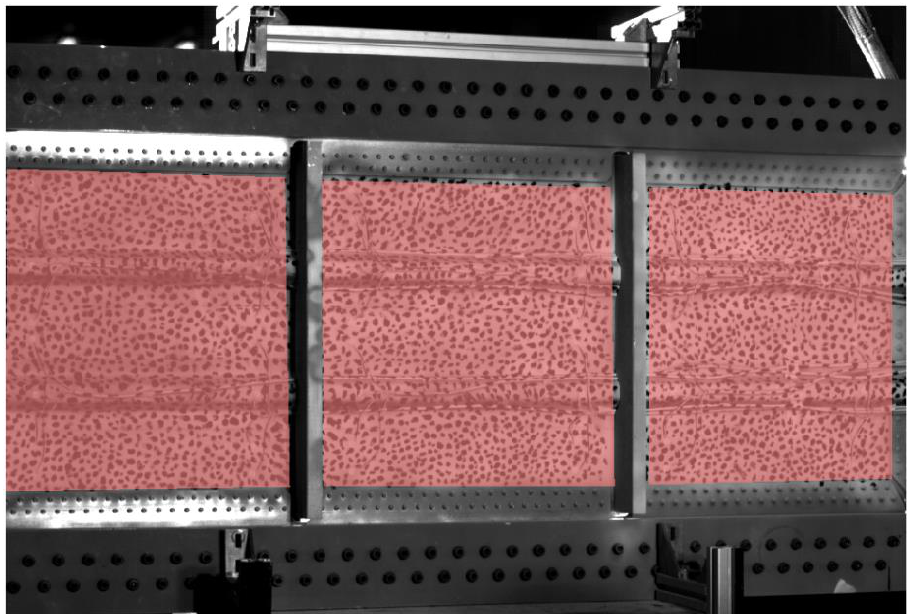
Figure 2. Schematic of the experimental setup for HS 3D-DIC measurement of the vibration response of a CFRP panel to multi-impact excitation using a gas gun.